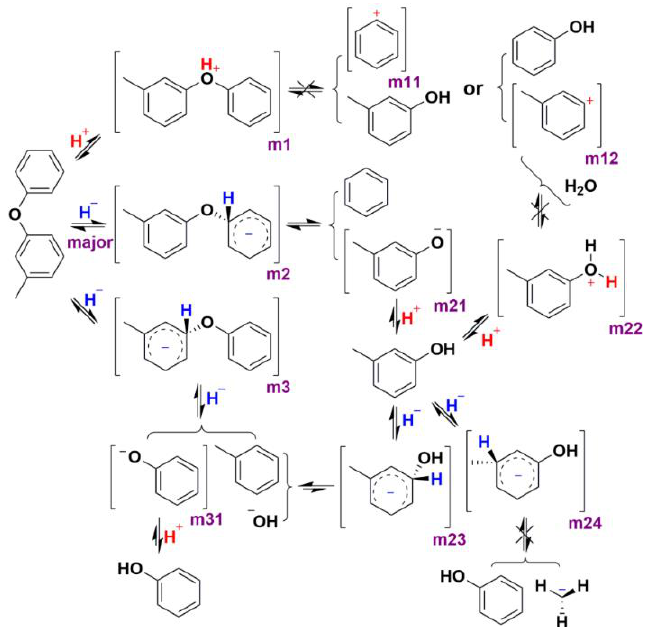
Scheme 1. Hypothesized pathways for hydrogenolysis of 3-methyl diphenyl ether over